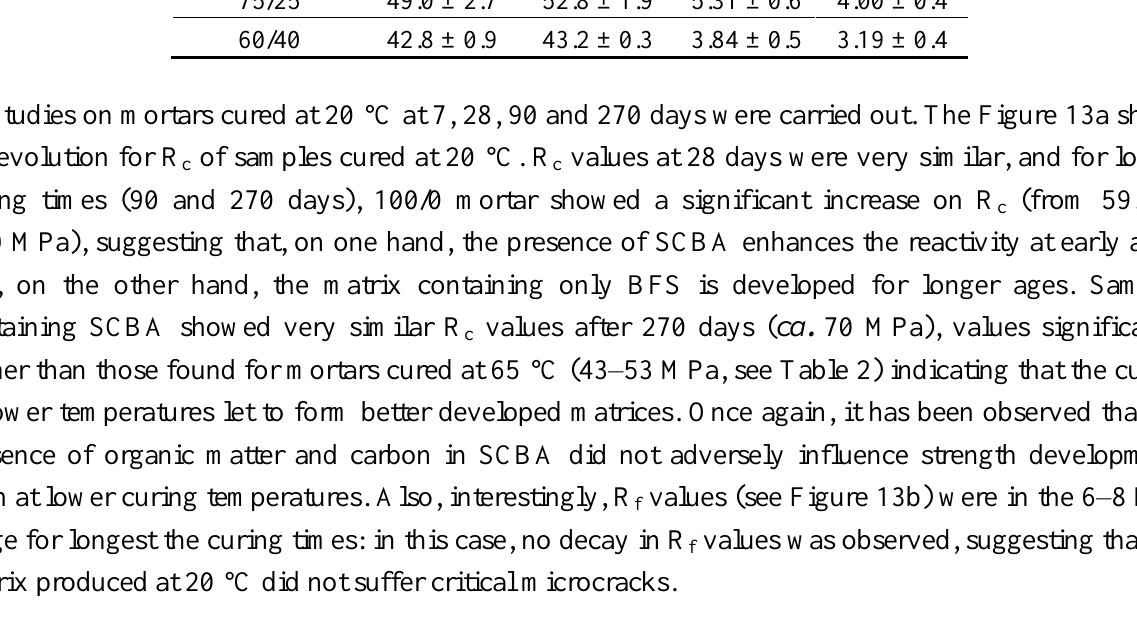
Figure 13. Mechanical strength developments for of BFS + SCBA mortars cured at 20 °C: ( a ) Compressive strength; ( b ) Flexural